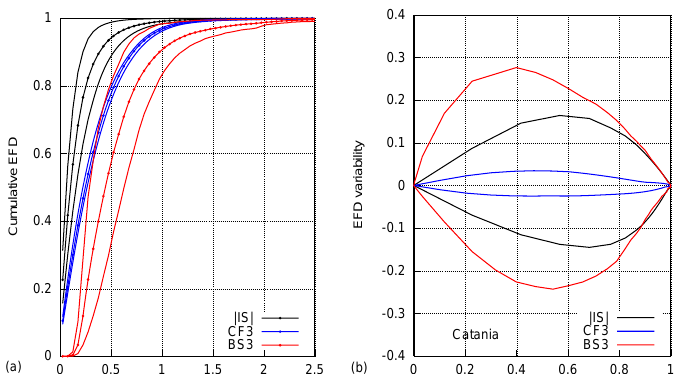
Fig. 8. Cumulative EFDs of the functions | IS | (black), BS3 (red) and CF3 (blue) for the whole base interval together with the maximum and minimum envelope of monthly EFDs for the configuration A3C2 (a) . Distance of the envelopes plotted against the cumulative EFD (b) .